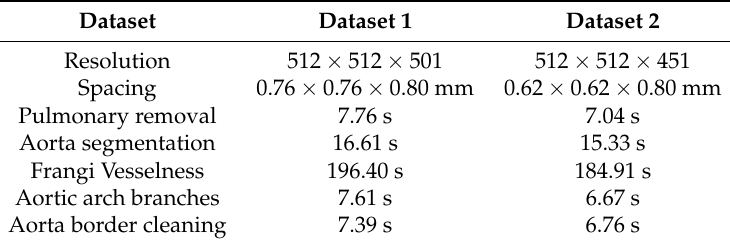
Figure 8. Results of cerebral arteries segmentation: ( a , b ) resulting segmentations, green—aorta, purple—cerebral arteries. Table 2. CPU times of cerebral arteries